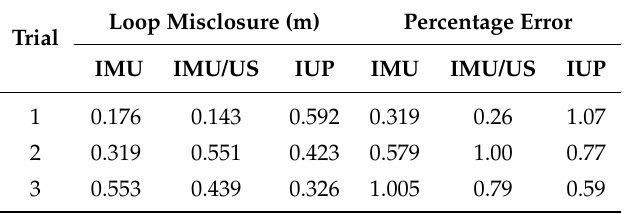
The loop misclosure and percentage errors of inertial measurement unit (IMU), IMU/ultrasound (US) and inertial/ultrasound/particle filter (IUP) systems for all three trials during Type 2 walking.